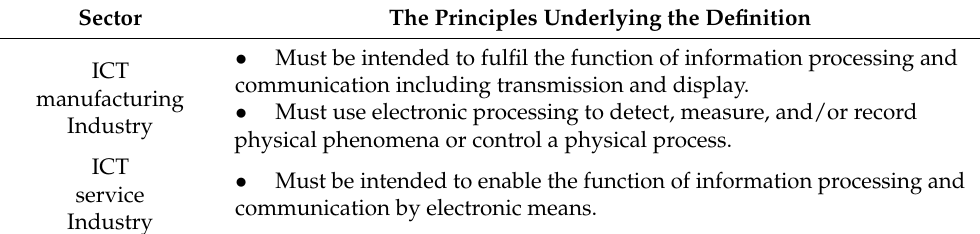
Table 2. Definition of ICT manufacturing and service